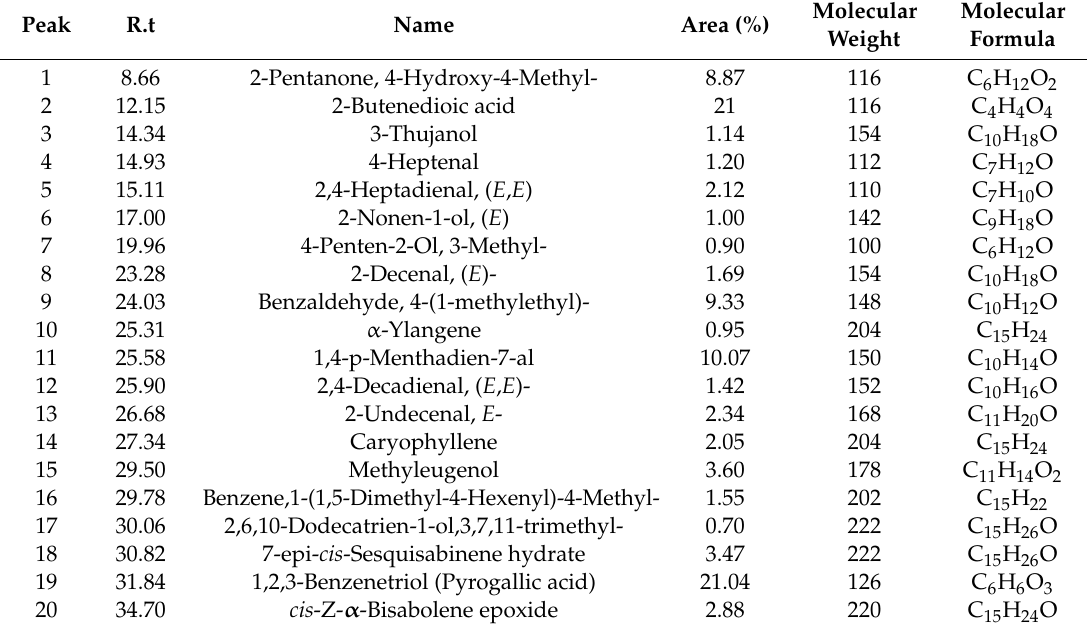
Table 2. The chemical composition of AERC by